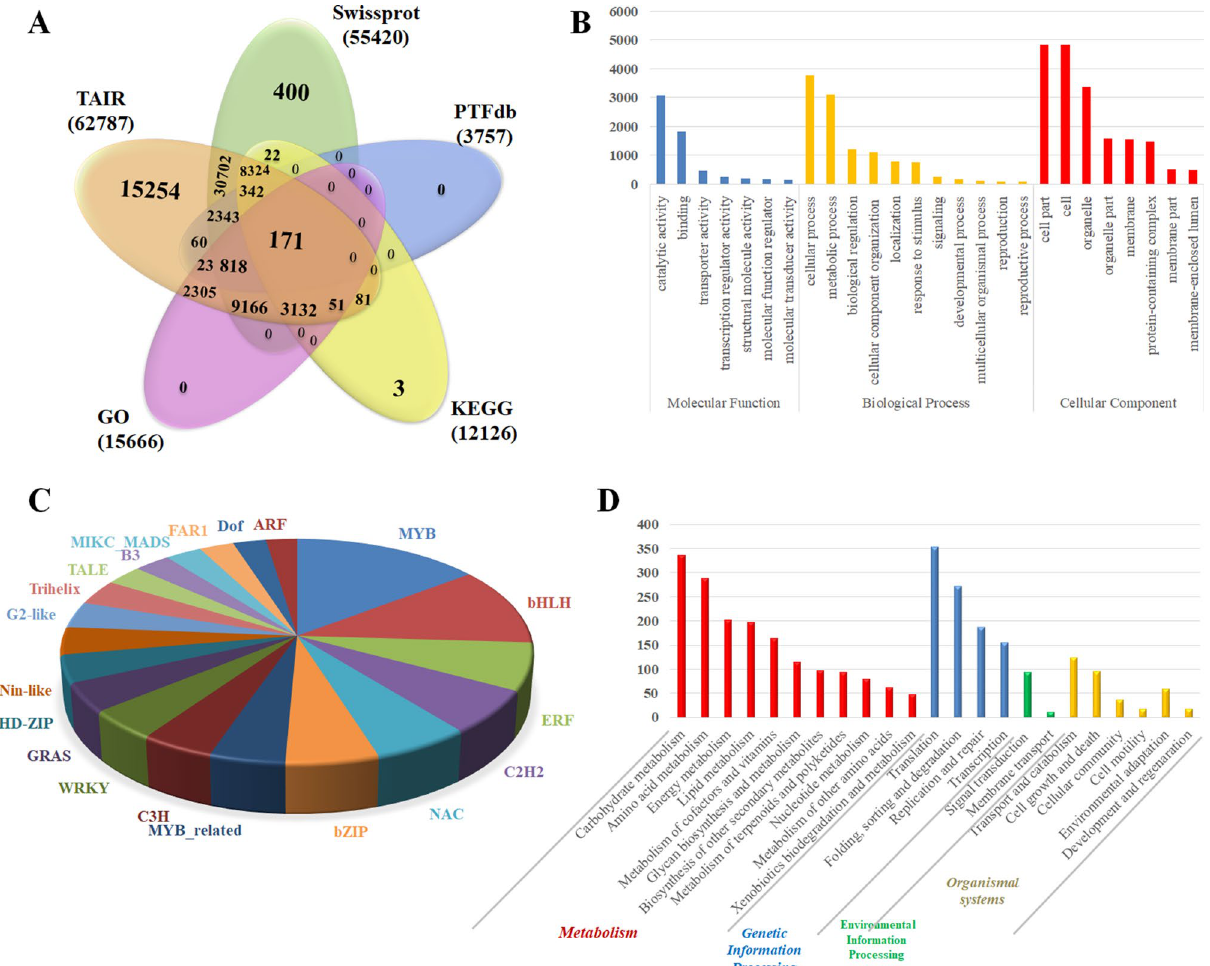
Figure 2. ( A ) Venn diagram of annotated transcripts in multiple databases. ( B ) Gene ontology classification of transcripts. ( C ) Frequency distribution of transcription factors in transcriptome data. ( D ) Functional classification and pathway assignment of assembled transcripts by